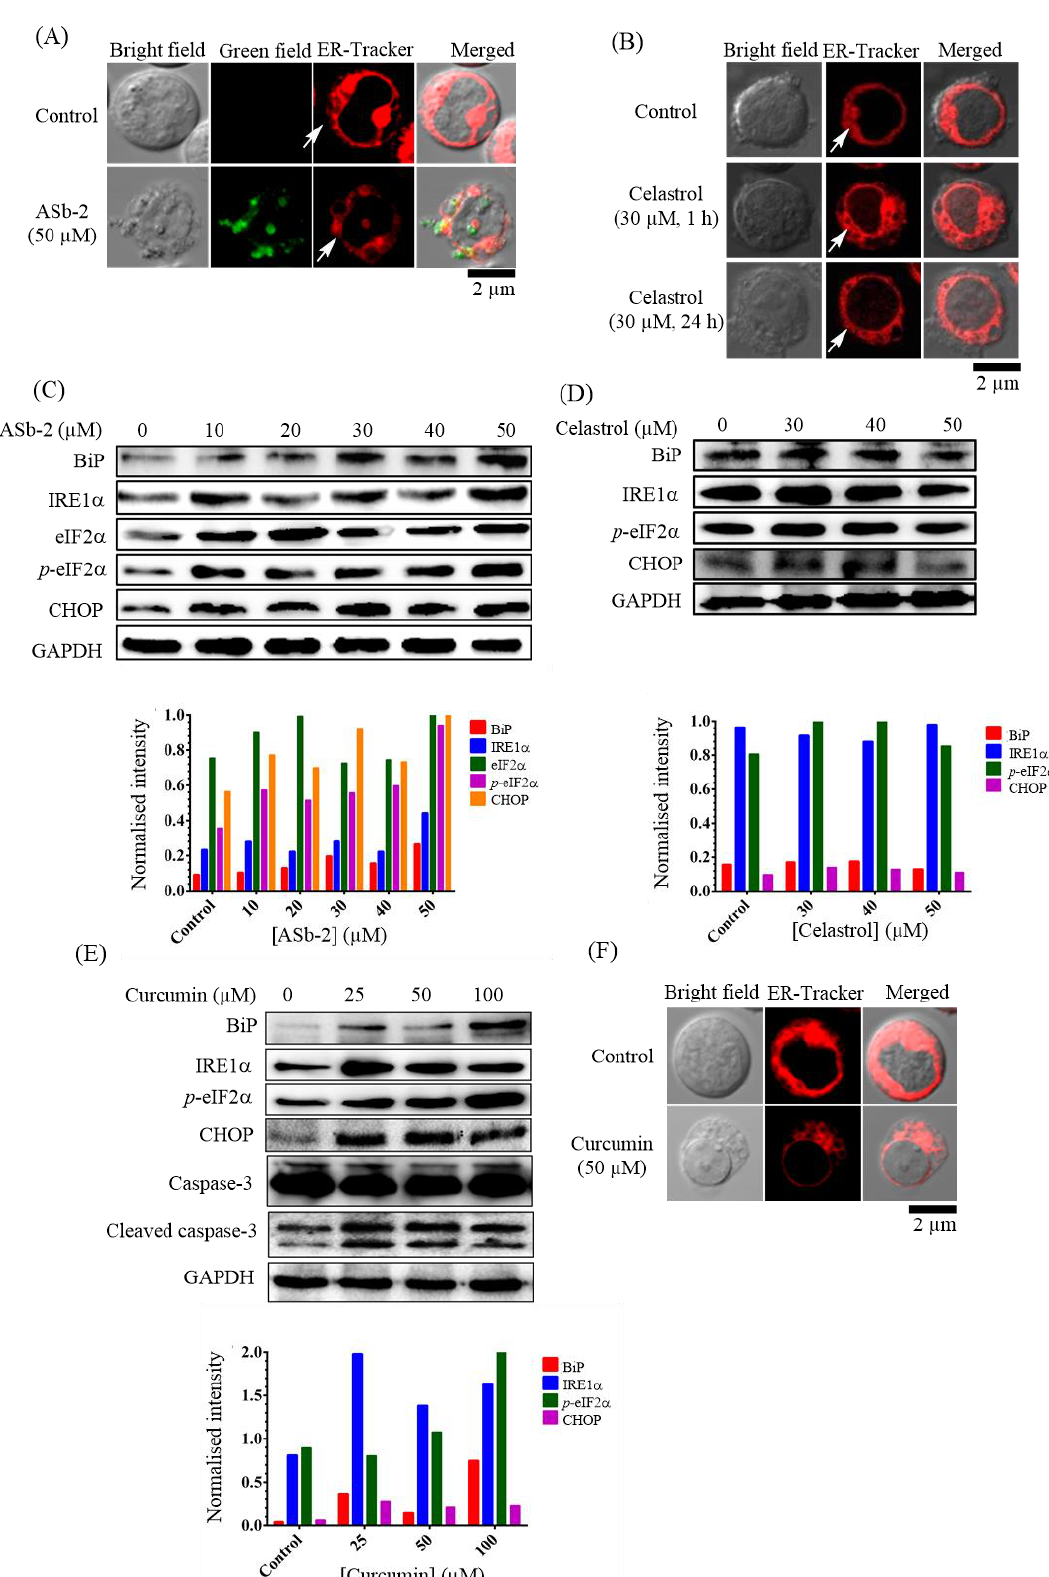
Figure 13. ( A ) Typical luminescence confocal microscopic images (Fluoview, FV-1000, Olympus) of Jurkat cells stained with ER-Tracker Red in the presence of ASb-2 (50 µM) for 1 h at 37 °C. ( B ) Typical confocal microscopic images (Fluoview, FV-1000, Olympus) of Jurkat cells stained with ER-Tracker Red in the presence of celastrol (30 µM) for 1 or 24 h at 37 °C. ( C ) Western blot analyses of ER stress markers such as BiP, IRE1 α , eIF2 α , p -eIF2 α , and CHOP in the presence or absence